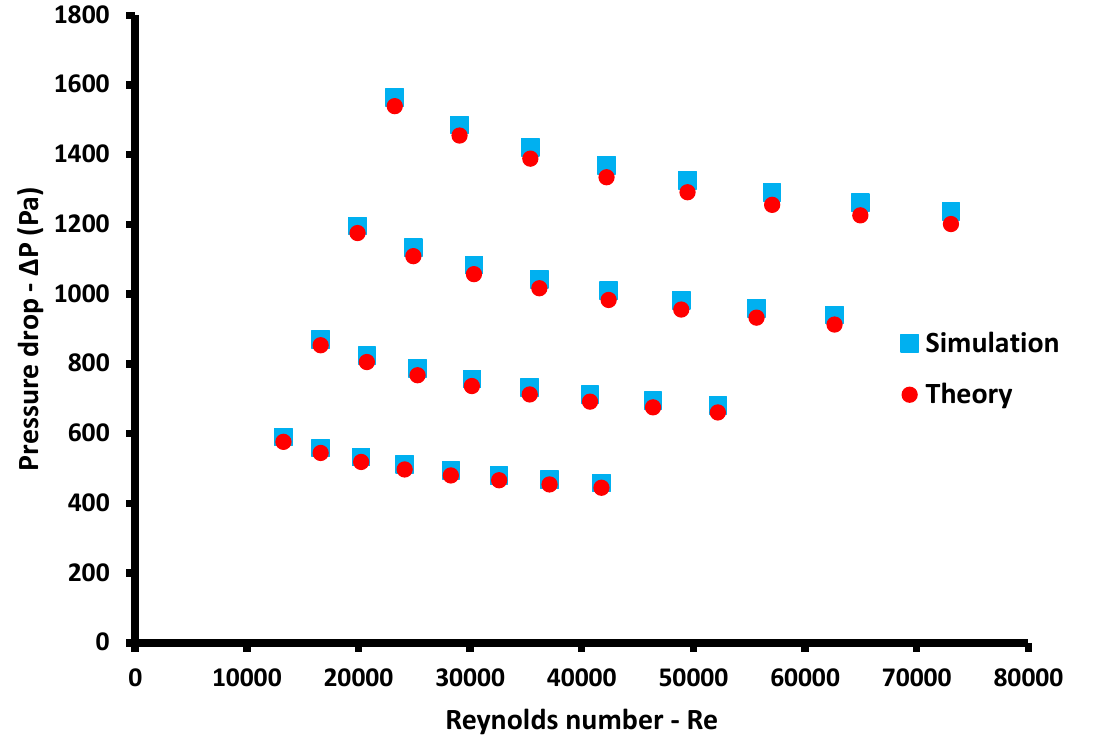
Figure 5. The pressure drop from simulation studies and theoretical calculations.